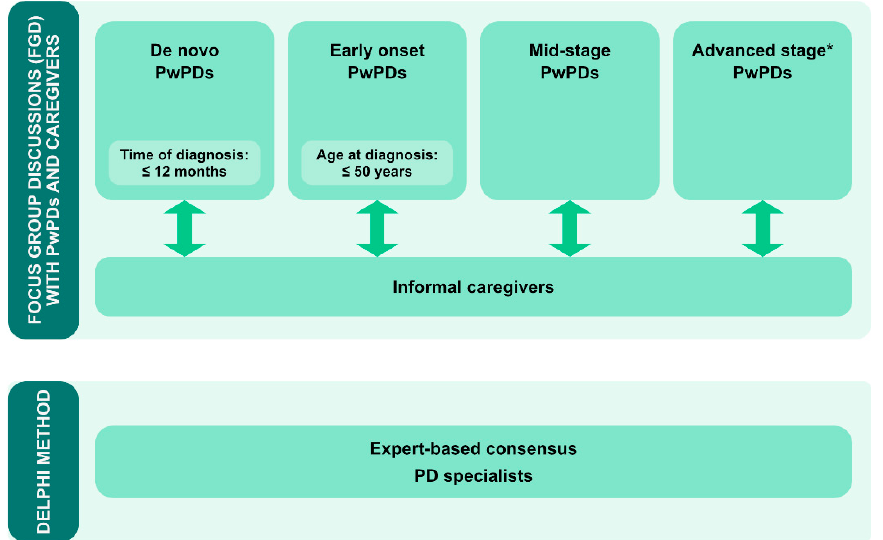
Figure 5. Concept for phase 1: structured assessment of needs of PwPDs and their caregivers by disease-stage specific focus groups (upper panel). Structured expert-based Delphi consensus process on expert recommendations on content, format and objectives of a PD-specific PME program. * Advanced disease stage will be defined according to [58].